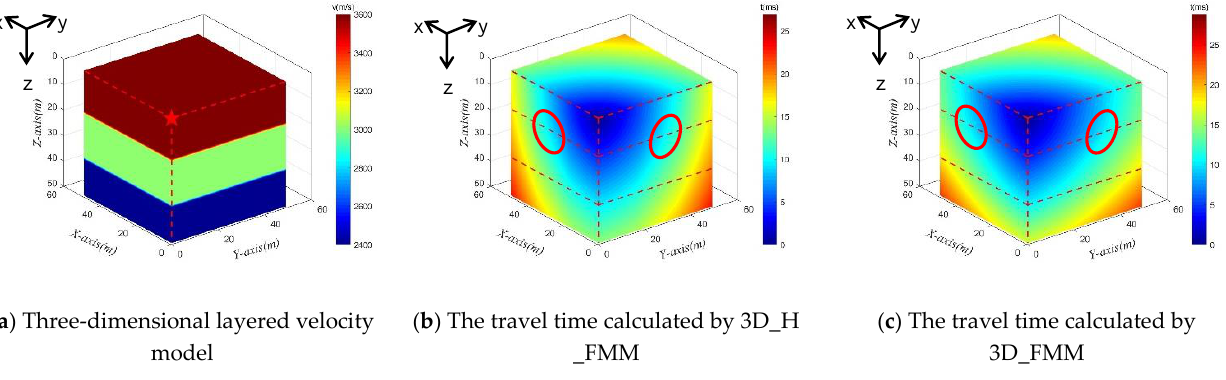
Figure 9. The Case C: small-scaled inhomogeneous velocity model and the travel time calculated by 3D_H_FMM and 3D_FMM.